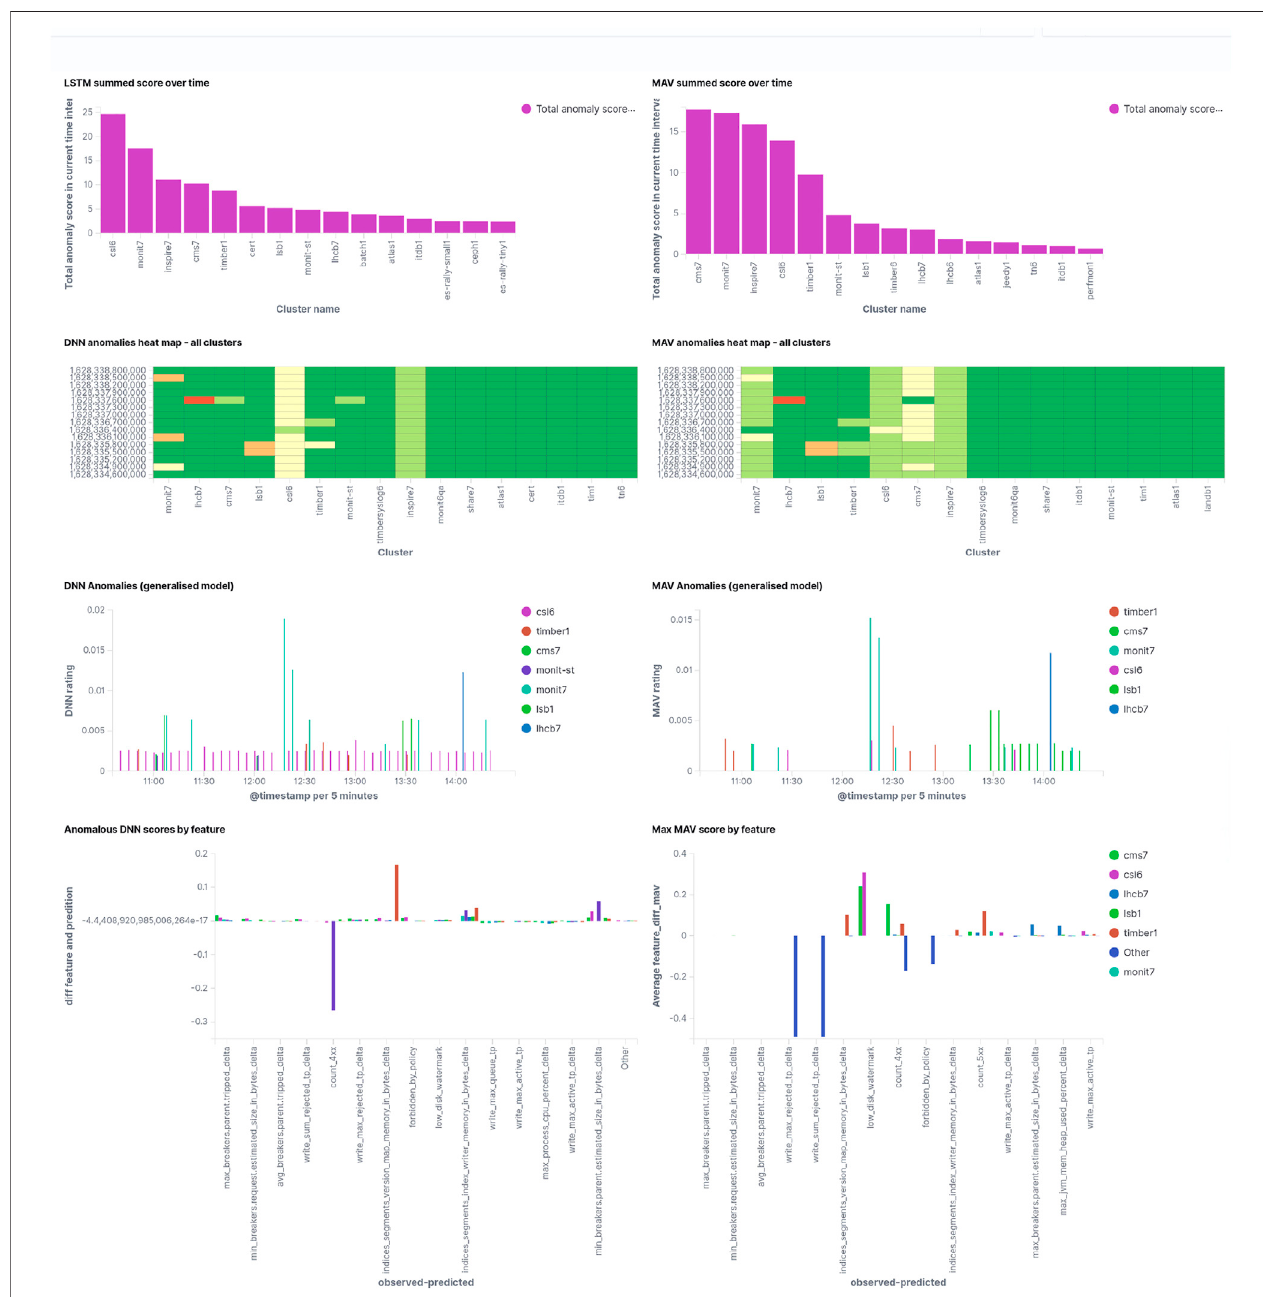
FIGURE7| Screenshotoftheanomaliesoverviewpageforservicemanagers,showingtheLSTM (left) andthemovingaverage (right) resultsforthelast4 hoursof operations. The upper row shows the accumulated anomaly score, giving an indication of what to look fi rst. The second row shows the last scores in 5 min steps, color encoded. Non-green bands indicate ongoing issues. The thirdrow shows all anomaly scoresby time whichexceed aspeci fi c threshold, and thefourth row shows input metrics with the largest deviation from the predicted value, thus giving an indication of what may be wrong.